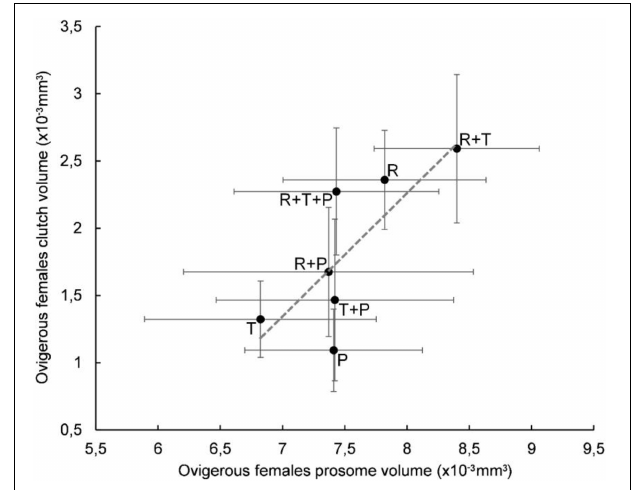
FIGURE 3 | Relationship between average prosome volume and clutch volume in Paracyclopina nana ovigerous females for each microalgal diet. Error bars show the standard deviations obtained from n = 20 females. Dashed line corresponds to the linear regression (EV = 0.9163 X PV – 5.069, R 2 = 0.5841, p < 0.01). Pearson’s test was performed to determine the significance of the coefficient of determination R 2 . R: Rhodomonas salina , T: Tisochrysis lutea , P: Pavlova